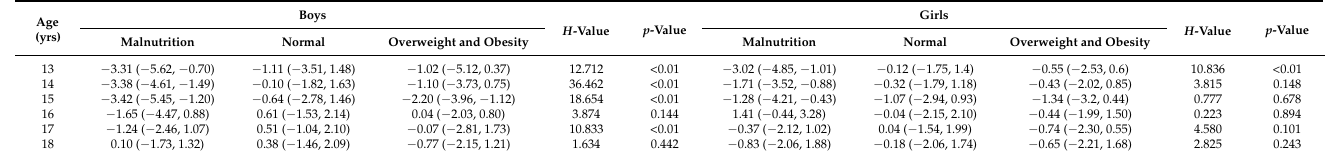
Table 2. Comparison of PFI of different nutritional status of Tibetan children and adolescents of different ages in high altitude areas (median (P25,